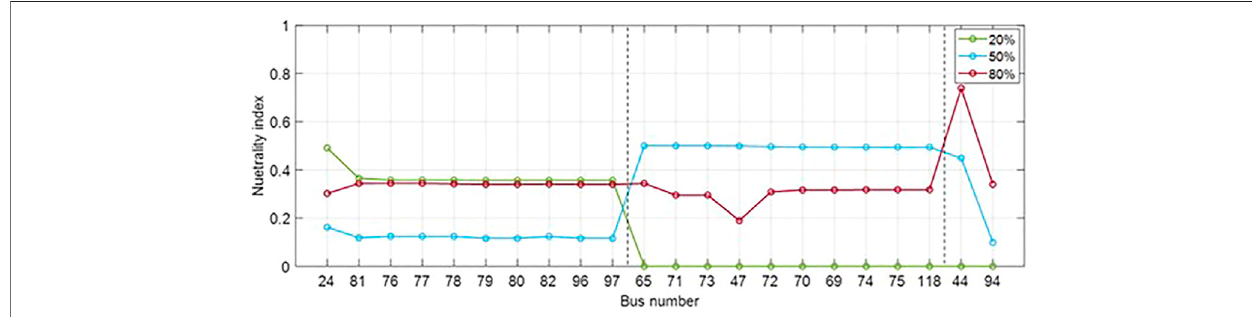
FIGURE 7 | Neutrality index results at each penetration level.